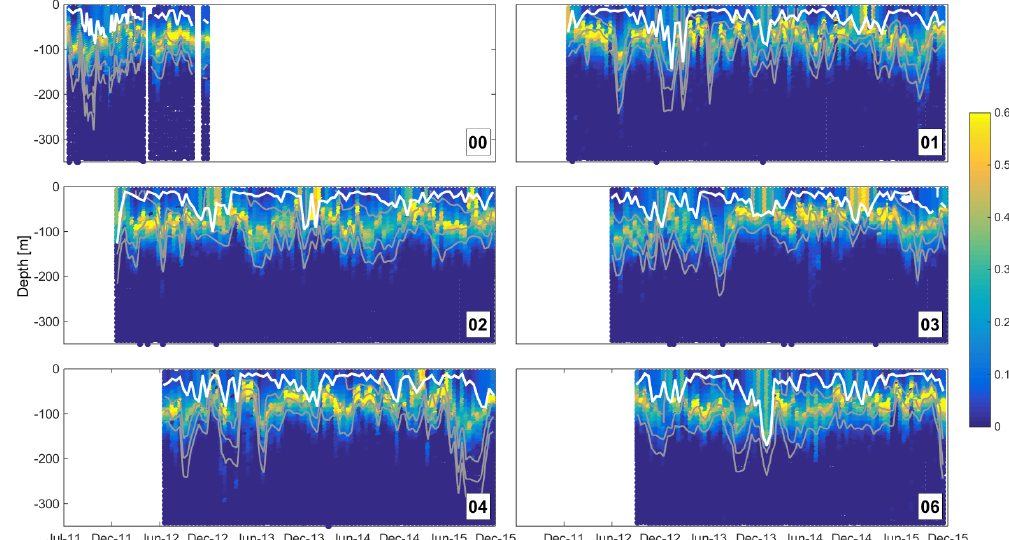
Figure 3. Calibrated [CHL] float transects in mgm − 3 . Contour plots of density (1024.5 1025.5 1026kgm − 3 , gray lines), and mixed-layer depth calculated as the depth where the difference of density from the surface reference, fixed at 10m-depth, is 0.03kgm − 3 (solid white line), are